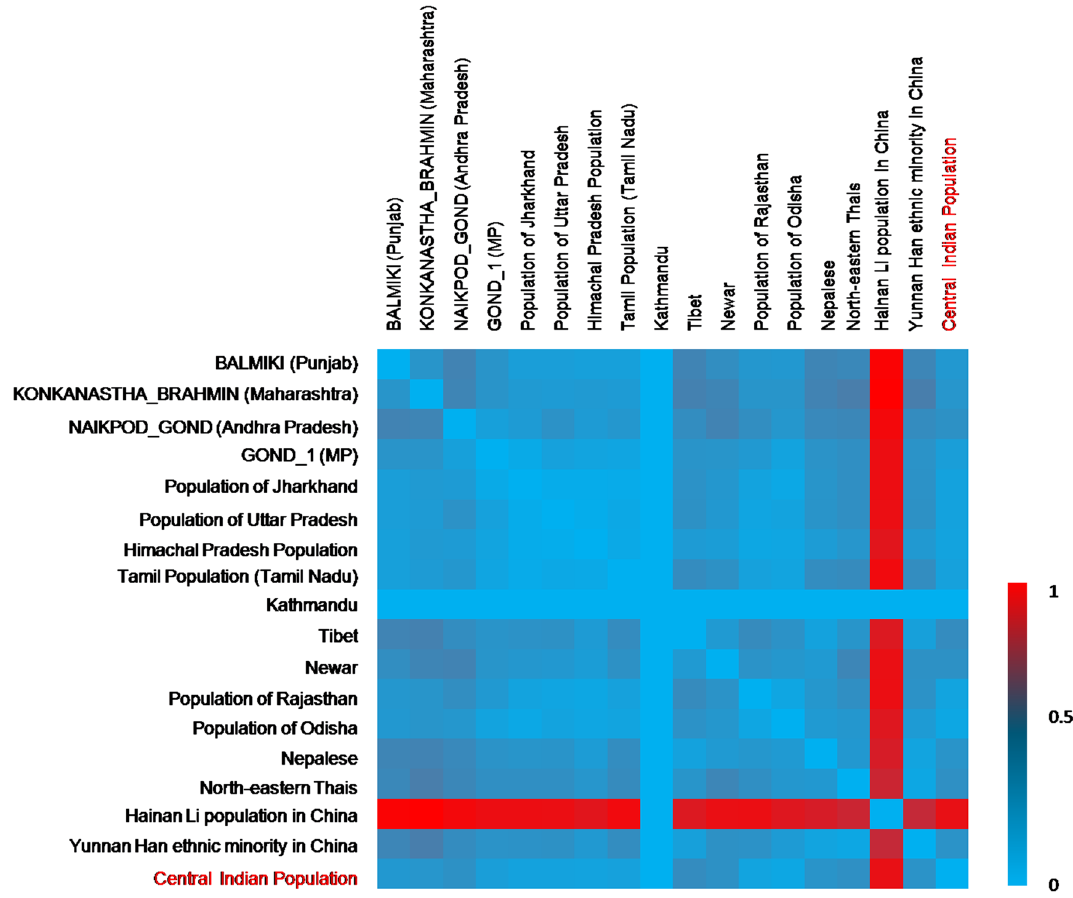
Figure 6. Interpopulation genetic structure at 15 consistent autosomal STR